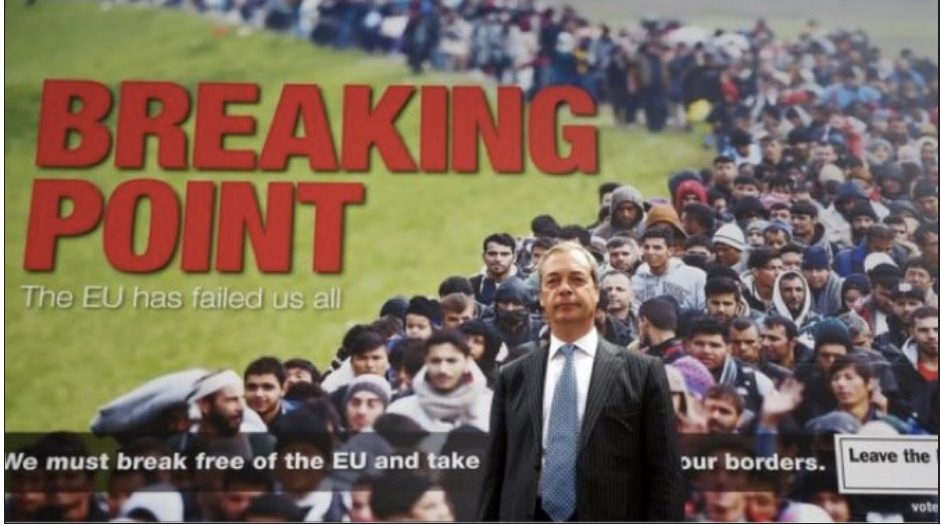
Figure 3: Nigel Farage and his much criticised ‘Breaking Point’ anti-EU poster, which shows a long queue of migrants (BBC